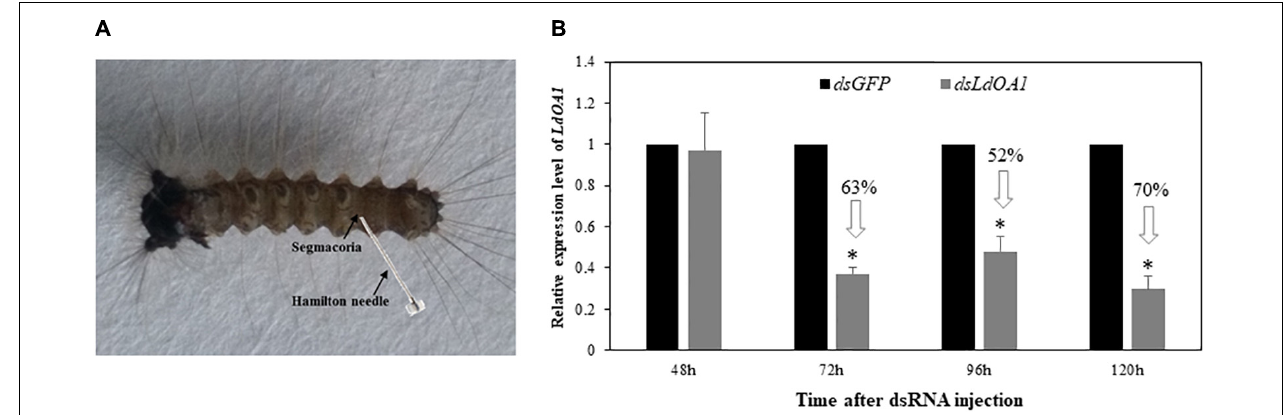
FIGURE 2 | Effect of RNAi on LdOA1 gene expression in 3 rd instar L. dispar larvae after dsRNA injection. (A) 3 rd instar L. dispar larva receiving dsRNA injection via the segmacorla. (B) LdOA1 transcript levels were determined by qRT-PCR for green fluorescent protein dsRNA-injected (ds GFP ) and LdOA1 dsRNA-injected (ds LdOA1 ) 3 rd instar L. dispar larvae. Data were normalized to three most stable reference genes Actin , EF1 α , and TUB . The 2 − (cid:49)(cid:49) CT method was used to calculate relative expression levels. The gene expression was shown as mean ± SD from three independent assays. Asterisk ( ∗ ) indicates significant difference according to Student’s t -test ( P < 0.05).